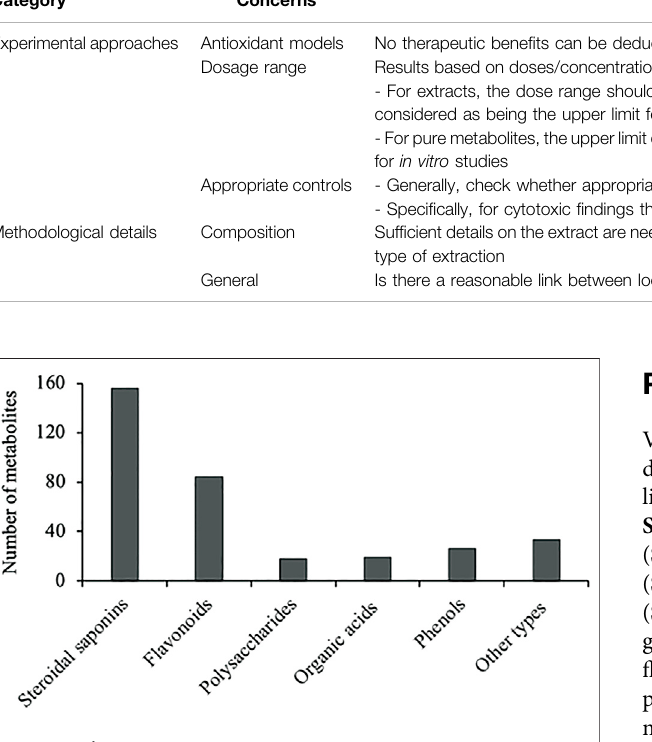
FIGURE 2 | Major classes of secondary metabolites isolated from